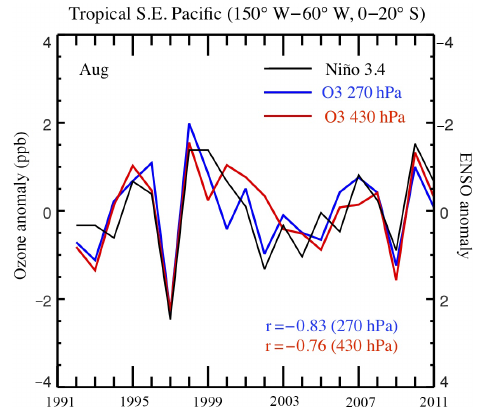
Figure 19. Comparison of IAV of ozone anomalies over the tropical southeastern Pacific region at 270hPa (blue) and 430hPa (red) with Niño 3.4 index in August from 1992 to 2011. The 2nd y axis for the ENSO anomaly is